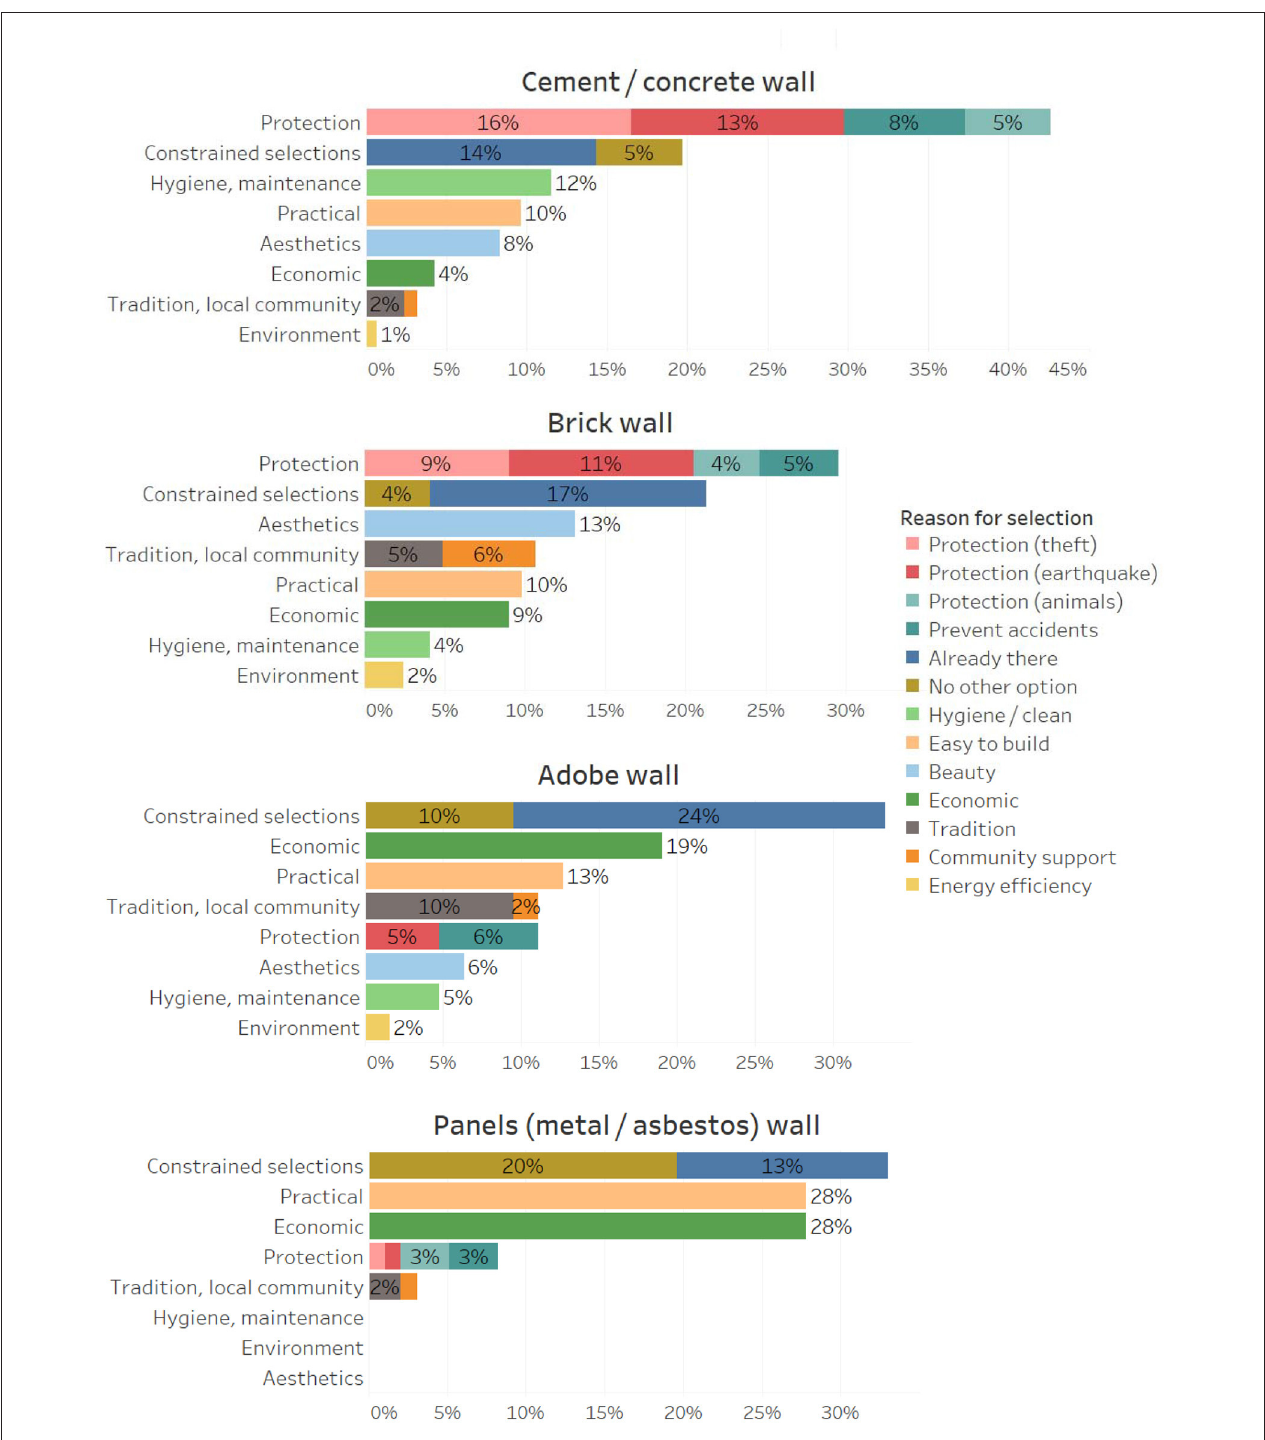
FIGURE 3 | Main reasons for wall material selection (percentage of total